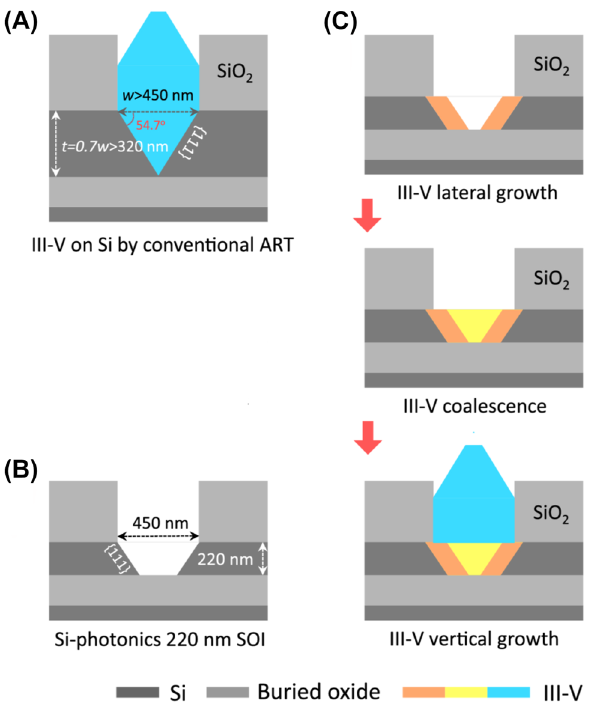
Figure 3: (A) Conventional aspect ratio trapping method with III–V epitaxial growth on a silicon V-groove. (B) Predefined trapezoidal groove on SOI wafer. (C) Designed growth sequence of bufferless III–V on Si-photonics 220 nm SOI platforms [55].